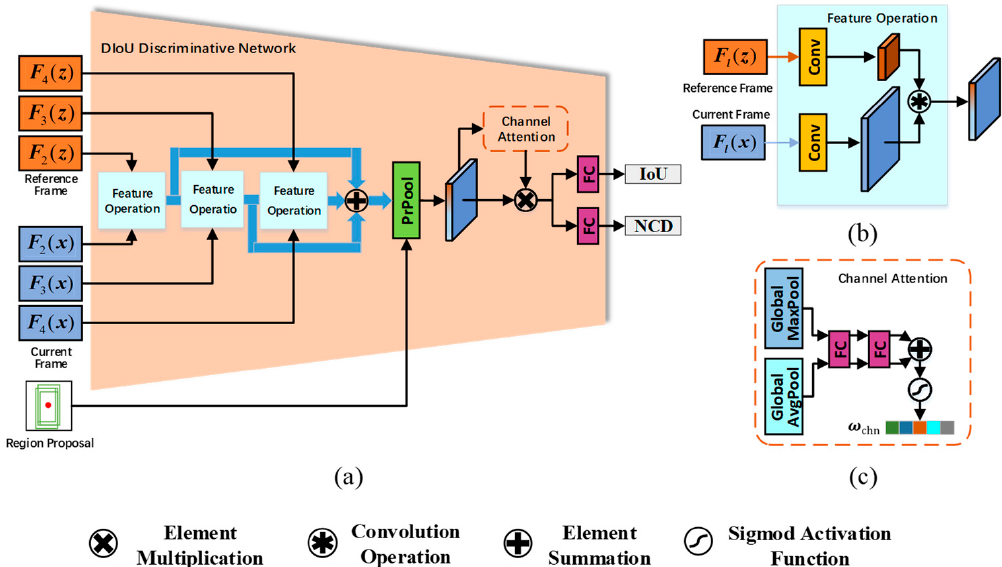
Figure 3. DIoU discriminative network with Multi-layer feature fusion. DIoU discriminative network fuses the extracted convolutional features of multiple layers, and finally obtains the DIoU score of the region proposal through PrPool operation and channel attention operation.